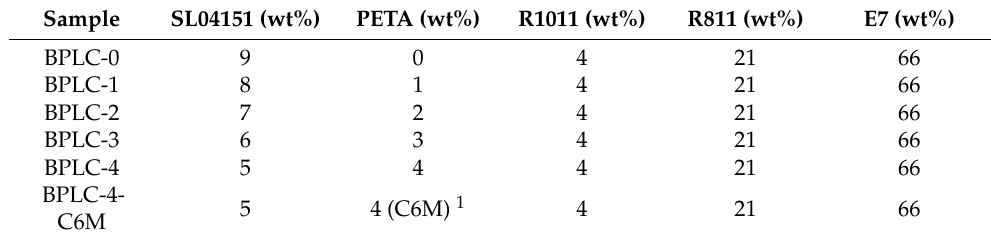
Table 1. Composition of BPLC mixtures used in this